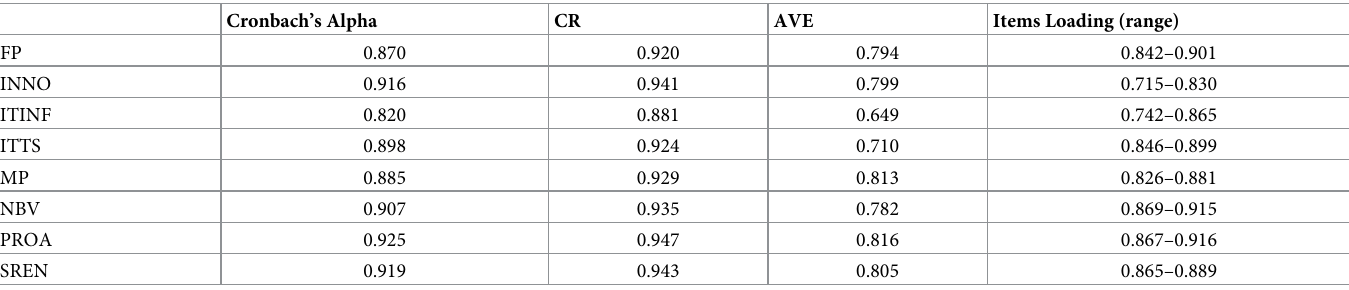
Table 3. Reliability and loading